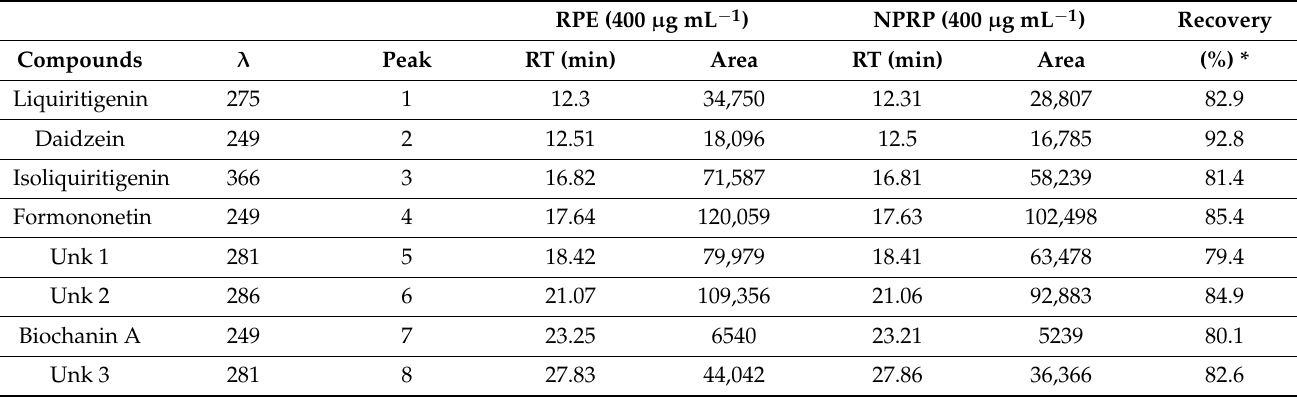
Table 3. Identification of red propolis markers by